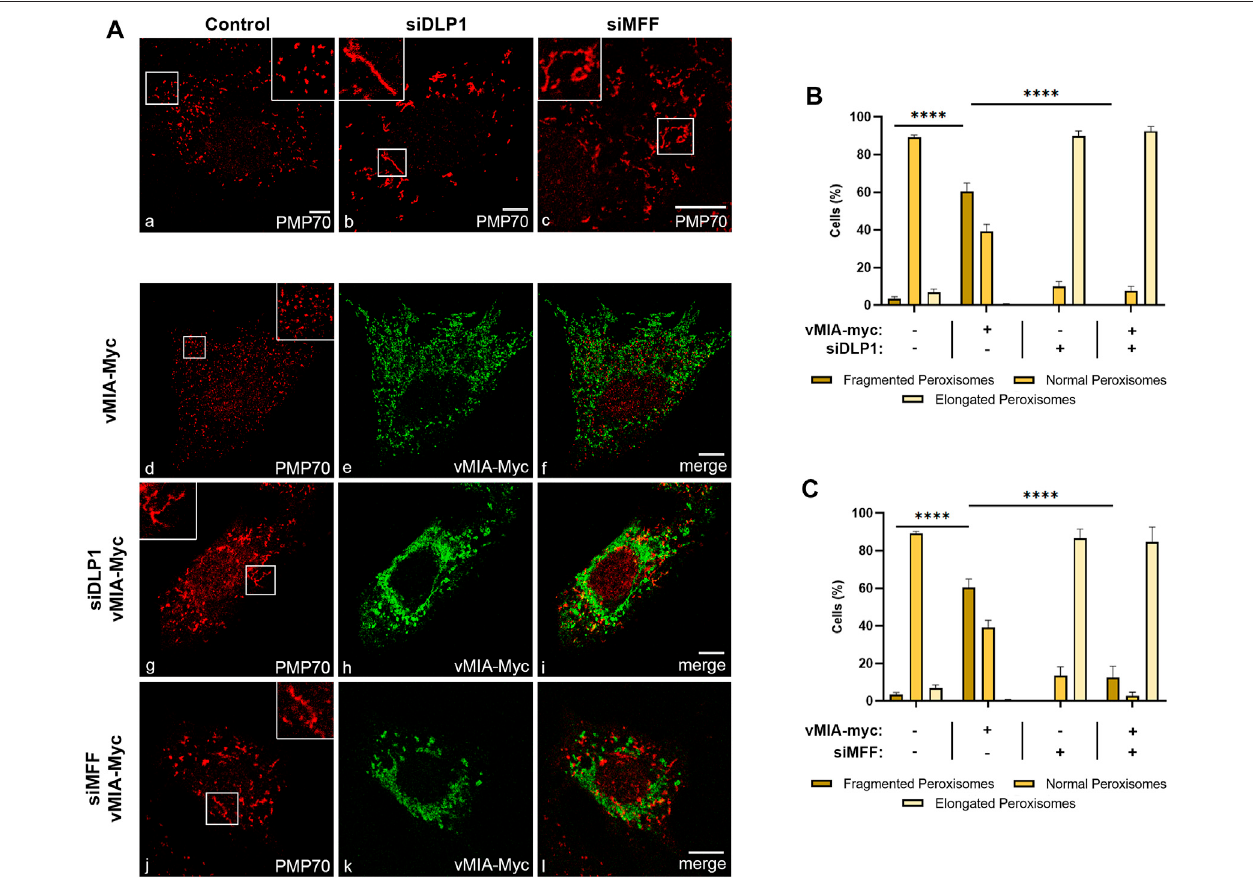
FIGURE1| vMIA-mediatedperoxisomalfragmentation isdependentonthe fi ssionmachinery proteins DLP1and MFF. (A) Immuno fl uorescenceanalyses ofMEFs MAVS-PEX cells: (a) control cells, (b) DLP1 silenced cells, (c) MFF silenced cells: (a – c) anti-PMP70; (d – f) overexpression of vMIA-Myc: (d) anti-PMP70, (e) anti-Myc, (f) mergeimageofdande;(g – i)overexpressionofvMIA-MycinDLP1silencedcells:(g)anti-PM70,(h)anti-Myc,(i)mergeimageofgandh;(j – l)overexpressionofvMIA-Myc in MFF silenced cells: (j) anti-PMP70, (k) anti-Myc, (l) merge image of j and k. Bars represent 10 µm. (B,C) Statistical analysis of peroxisomal morphology upon overexpression of vMIA-Myc in MEFs MAVS-PEX cells in the absence of DLP1 or MFF, respectively. Approximately 600 cells were analysed per condition. Data representsthemeans±SEMofthreeindependentexperimentsanalysedusingtwo-wayANOVAwithBonferroni ’ smulticomparationstest(ns=non-signi fi cant,**** – p < 0.0001). Error bars represent